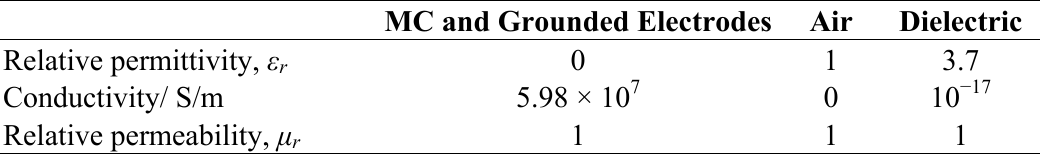
Table 2. Simulation parameters utilized in the current